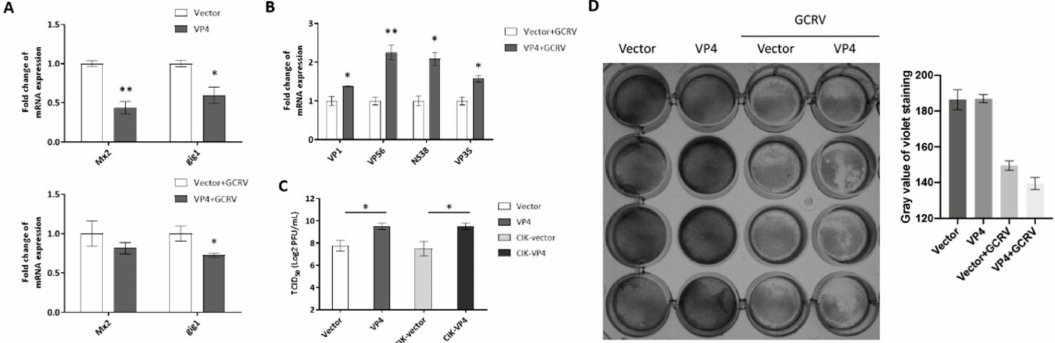
Figure 6. VP4 facilitated GCRV replication. ( A ) VP4 overexpression dampened ISGs mRNA